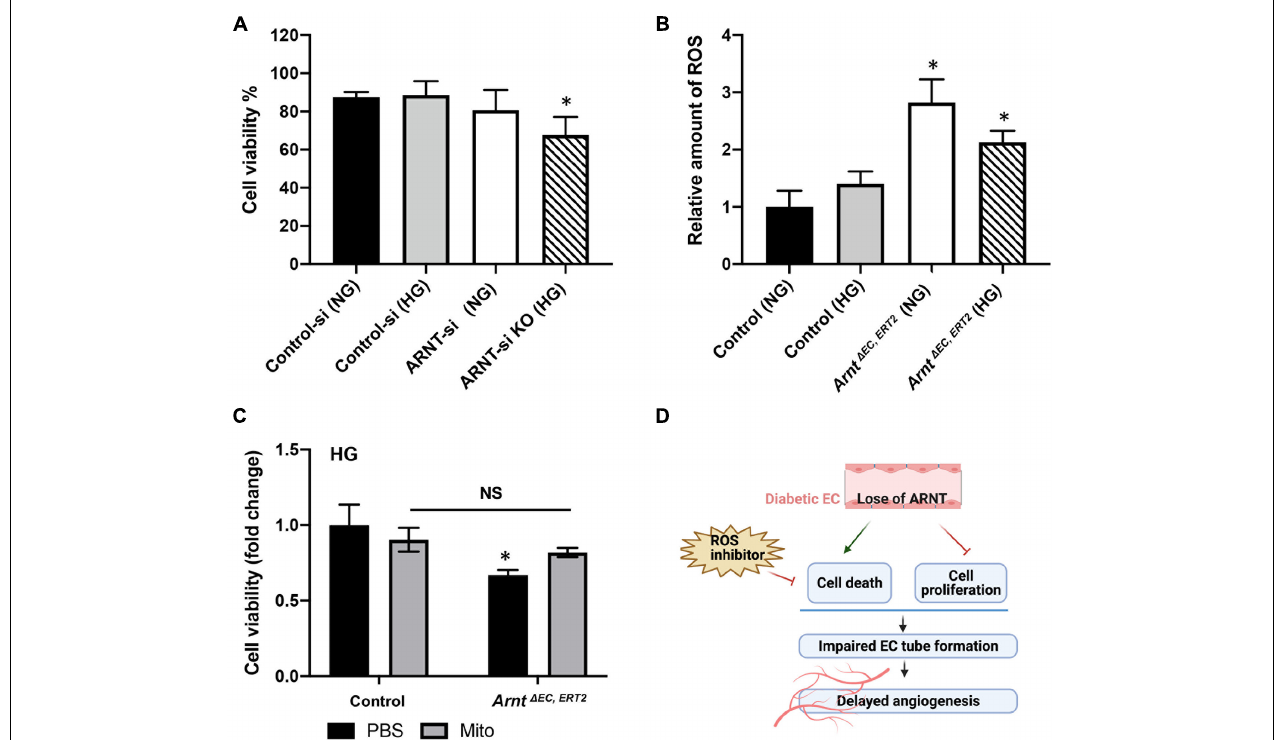
FIGURE 6 | Effects of ARNT expression on cell viability and cellular reactive oxygen species (ROS) production under either high glucose (HG) or normal media (NG) conditions. (A) Cell viability in the presence of high glucose or control media with and without ARNT deletion in HUVECs as indicated. ARNT knockdown was induced with an siRNA transfection. The treatment of a control siRNA serves as control. (B) ROS levels in MMVECs isolated from Arnt (cid:49) EC , ERT2 and Arnt fl / fl WT mice under high glucose. The ROS levels were assessed using the Cellular ROS/Superoxide Detection Assay Kit from Abcam. (C) Effect of inhibition of ROS by Mito-TEMPO on cell viability. Isolated MMVECs from Arnt (cid:49) EC , ERT2 and Arnt fl / fl WT control mice were cultured for 48 h in HG media followed by 24 h of administration of Mito-TEMPO at 0.5 µ M. Cell viability was measured as before using the Moxi GO II machine. The data are shown as mean ± SEM ( n = 6–8 per group). ∗ P < 0.01. (D) Schematic diagram of the role of endothelial ARNT in diabetic